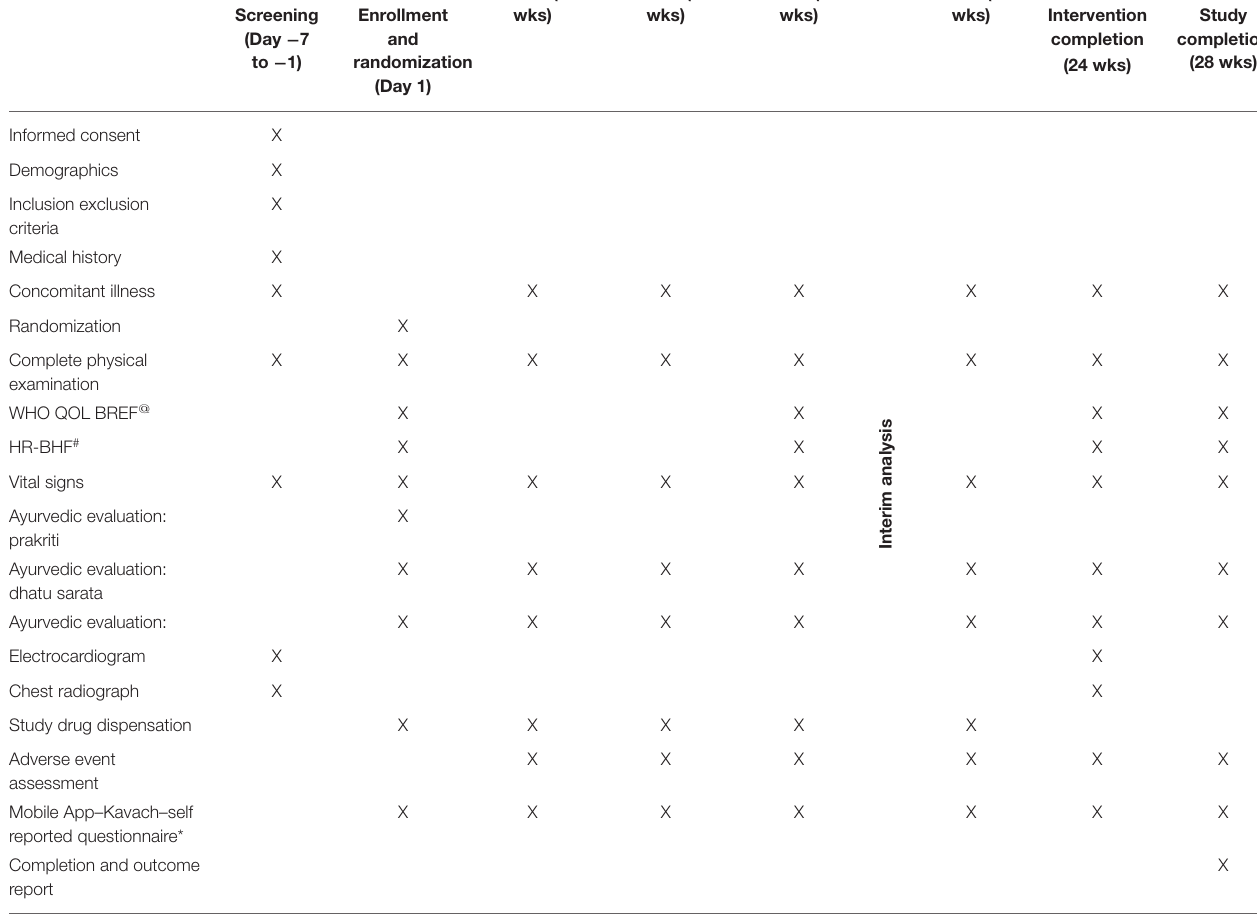
TABLE 1 | Clinical assessment